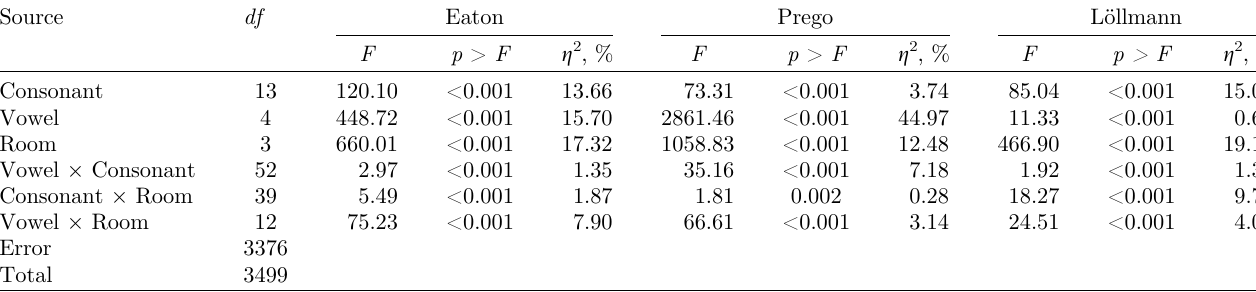
Table 4. VCV set of logatomes: ANOVA tables for the three algorithms. Source df Eaton Prego